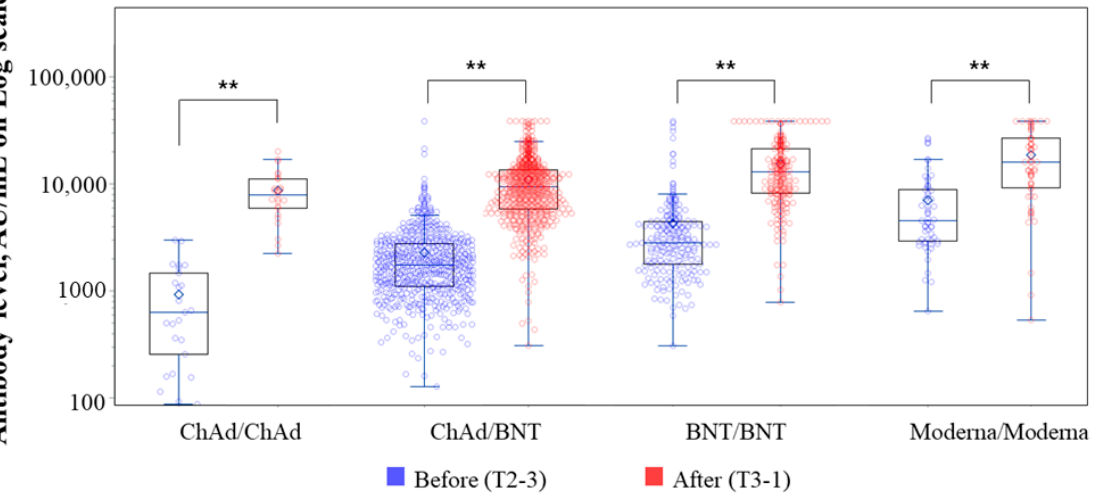
Figure 1. Anti-SARS-CoV-2 S-RBD IgG levels before (T2-3) and after (T3-1) the third vaccine in each group. Abbreviations: (T2-3), 3 months after the second dose; (T3-1), 1 month after the third dose. ** p -values ( p < 0.001) were calculated using the paired t -test.